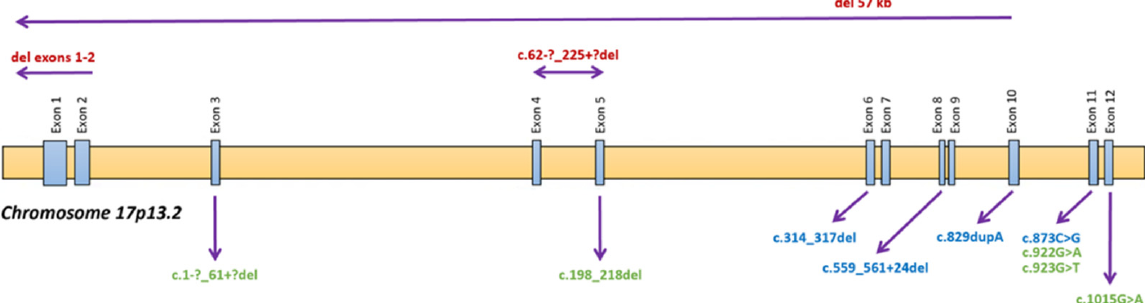
Figure 2. Topography of the mutations in the CTNS gene in this cohort. Schematic illustration of the CTNS gene with display of the mutations’ genomic location within our cohort. Exonic mutations are displayed in the bottom area of the figure. Large deletions are displayed in the top area. Green: residual activity (RA); Blue: inactive protein (IP); Red: absent protein (AP). Table 5. Justification of the classification of the mutations.